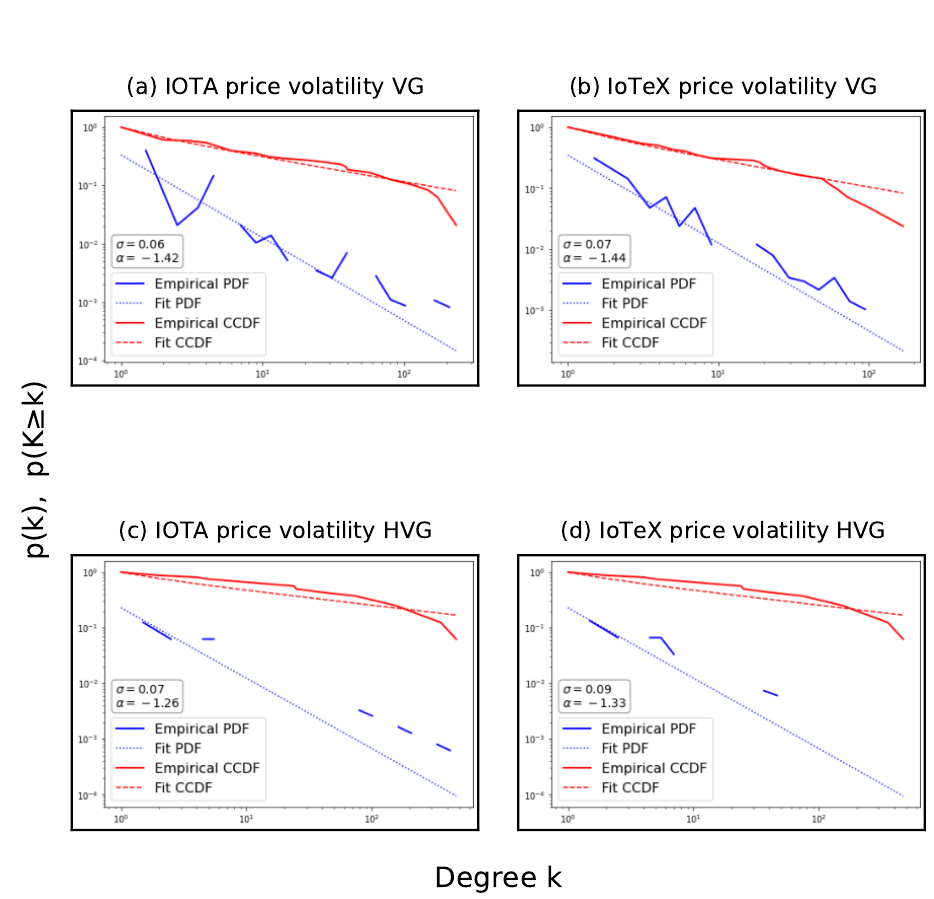
Figure 4. Both empirical and fit probability density functions (PDF) and complementary cumulative distribution functions (CCDF) using the powerlaw module by Alstott et al.